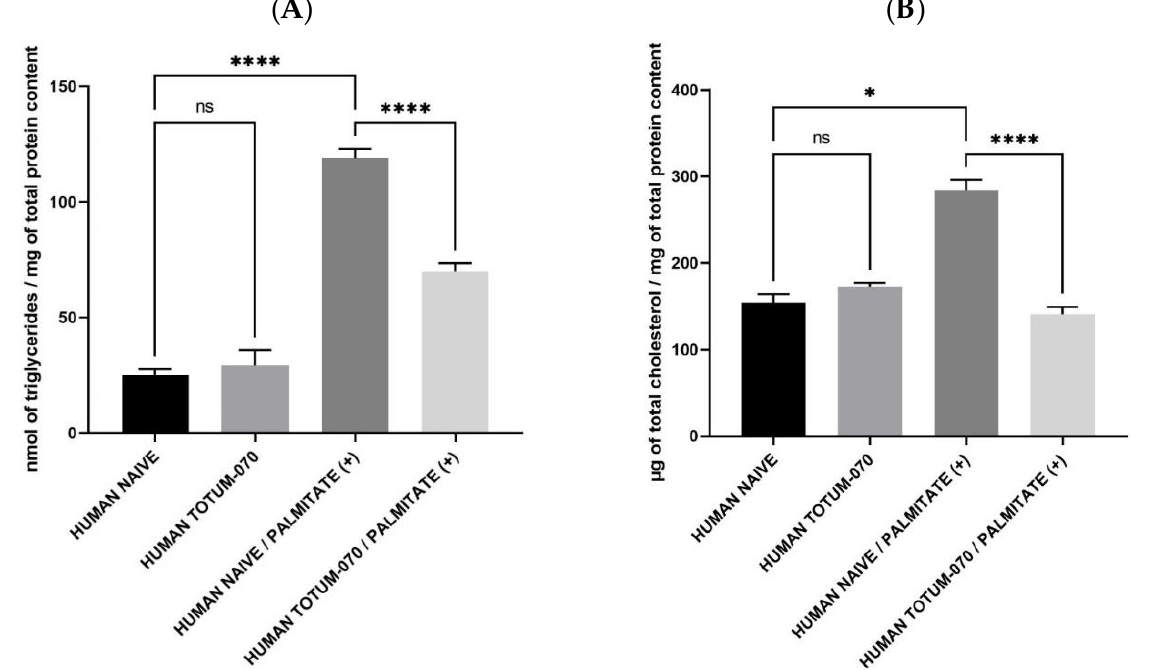
Figure 5. Quantification of intracellular lipid stocks. ( A ) Triglyceride content. ( B ) Cholesterol content. Measures were performed in quadruplicates per condition/volunteer ( n = 10 volunteers). Values are presented as the means ± SEM unless specified otherwise. The differences were considered statistically significant at p < 0.05 with * for p < 0.05; **** for p < 0.0001 and ns for p > 0.05. Triglycerides: (global p -value < 0.0001; Kruskal–Wallis statistic = 59.31); Total cholesterol (global p -value < 0.0001; Kruskal–Wallis statistic = 52.95).